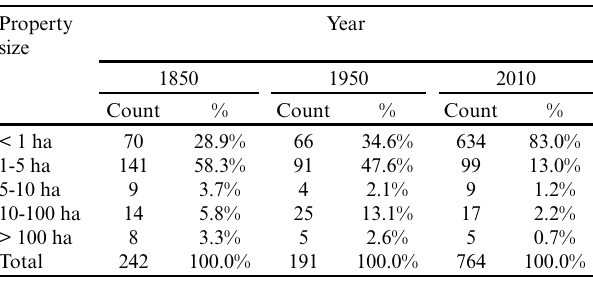
Table 6 . Count and percentage of landowners according to property size for years 1850, 1950, and